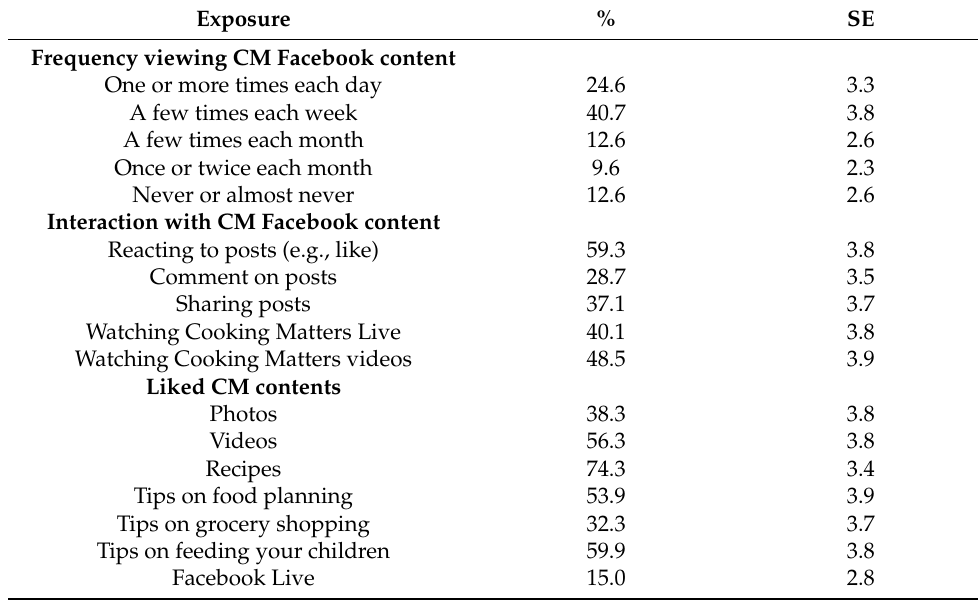
Table 5. Exposure to Cooking Matters (CM) Facebook content among followers ( n =